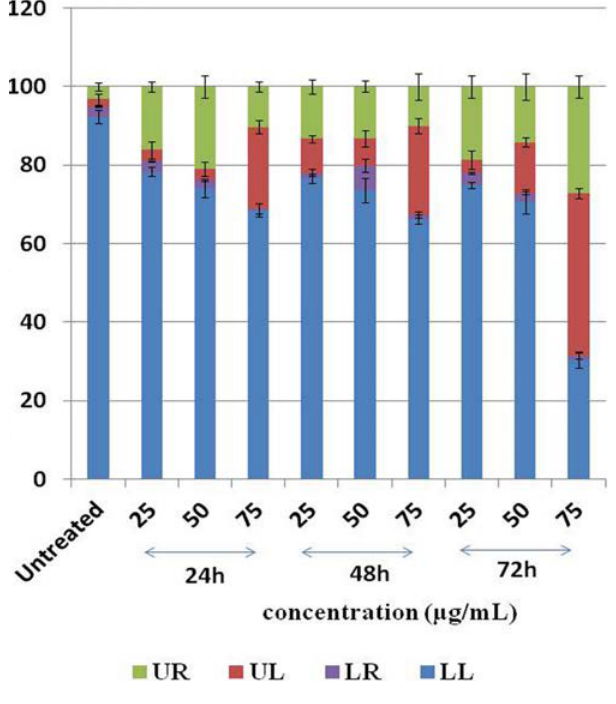
Figure 6. Histogram representation of the quantitative percentage of viable cells (LL), early apoptotic cells (LR), necrotic cells (UL) and late apoptotic cells (UR) of HT-29 treatment with different concentration of DMHE for 24, 48 and 72 h. Viable cells = LL; Early apoptotic cells = LR; Late apoptotic cells or dead cells = UR; Necrotic cells =